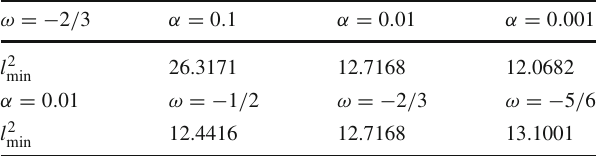
Table 1 Minimum values of cosmological constant l 2 parameters